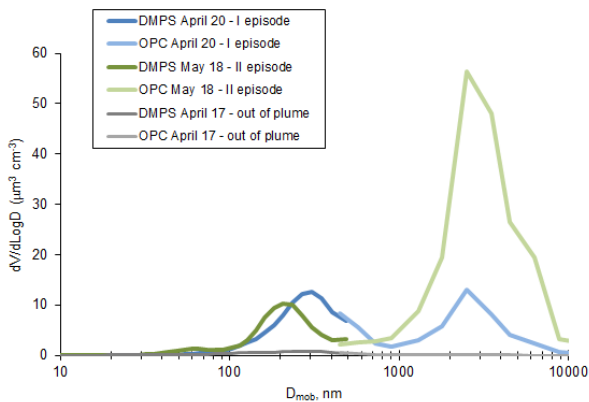
Fig. 5. Comparison between the aerosol size distribution before the Figure 5. Comparison between the aerosol size distribution before the arrival of the volcanic 2 arrival of the volcanic plume, 17 April (black/grey – out of plume), plume, April 17 (black/grey – out of plume) and during its most intense impact on April 20 3 and during its most intense impact on 20 April (blue/light blue – I (blue/light blue – I episode) and May 18 (green/light green – II episode), derived from DMPS 4 episode) and 18 May (green/light green – II episode), derived from (10-500 nm) and OPC (300 nm - 20µm) measurements.5 DMPS (10–500nm) and OPC (300nm–20µm)